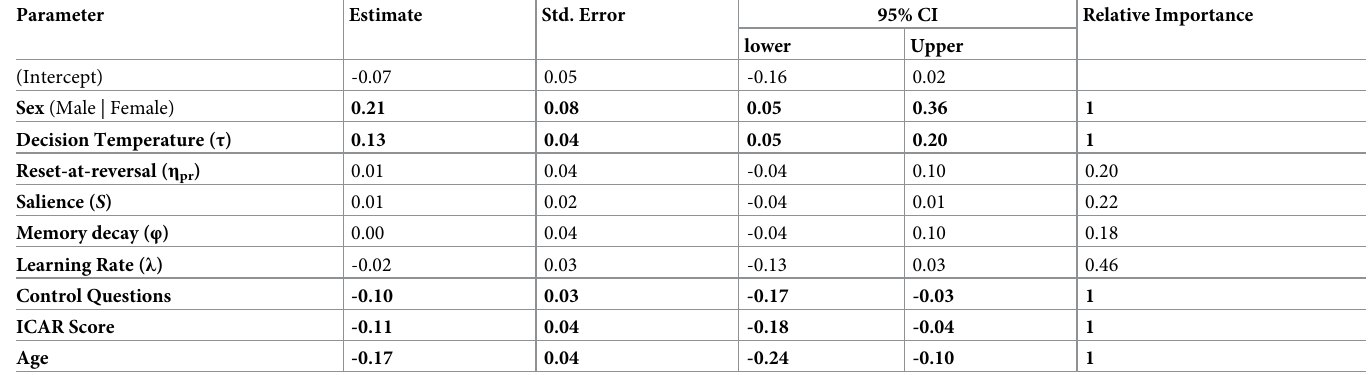
Table 1. Top Model Average of Parameters Associated with Pre-Existing Paranoia in the Probabilistic Reversal Task. All regression estimates are extracted from Model P6 in the analysis